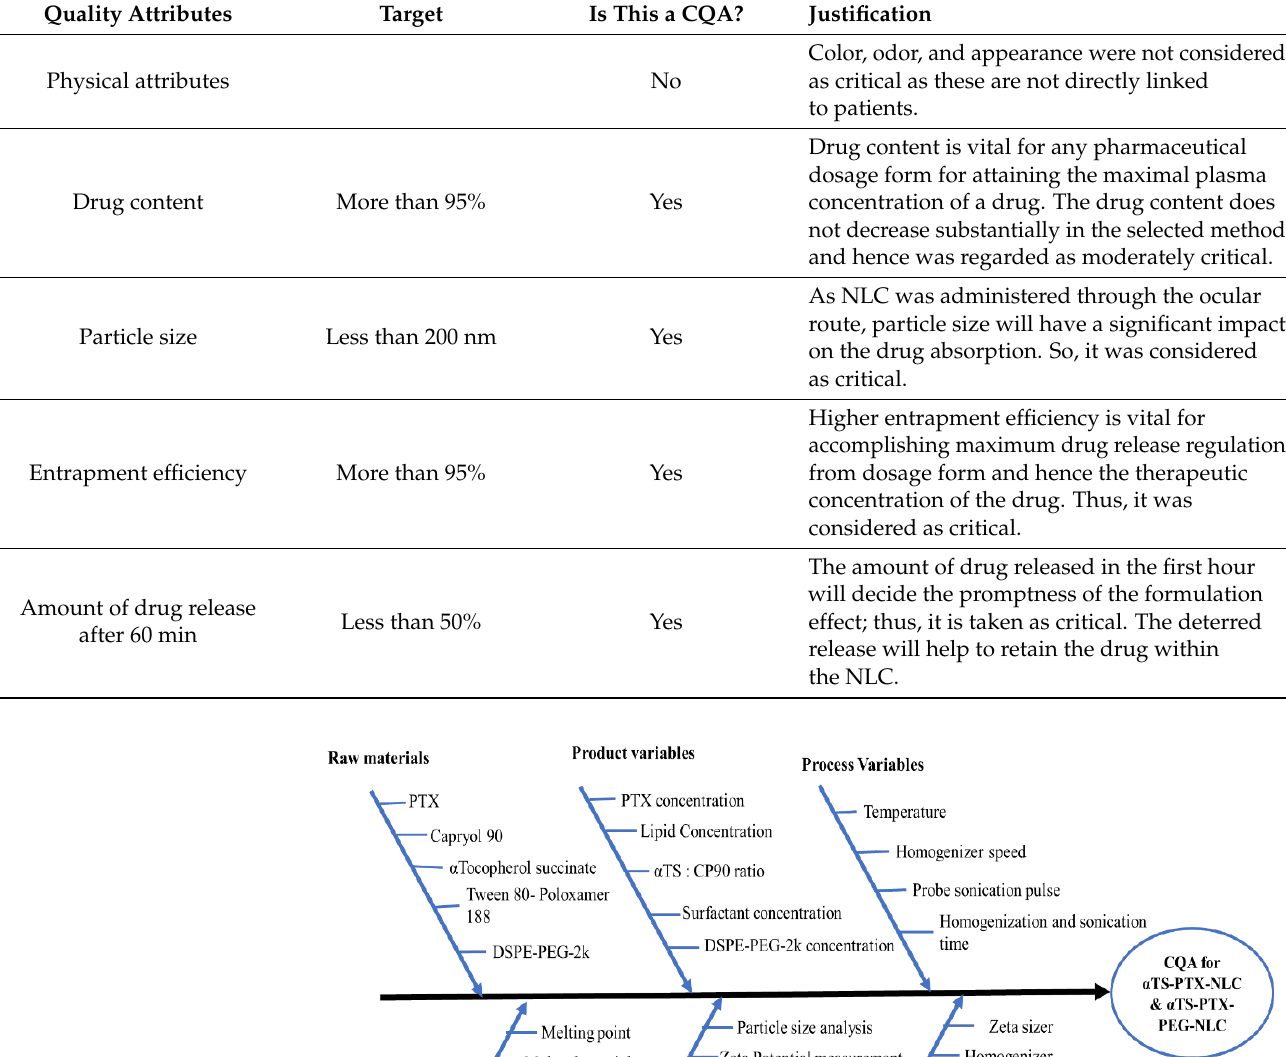
Table 2. Critical Quality Attributes (CQA) used for the PTX-NLC.